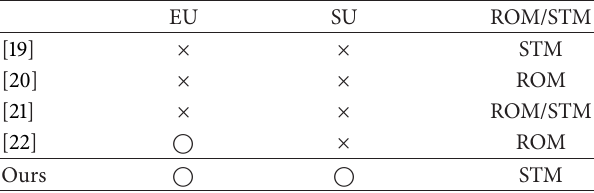
Table 1: Comparison of ring signature